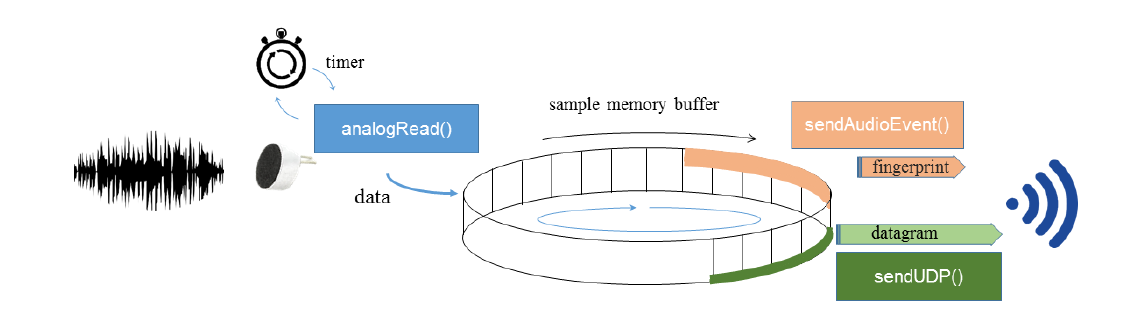
Figure 5. Graphical flow diagram implemented in the wireless acoustic